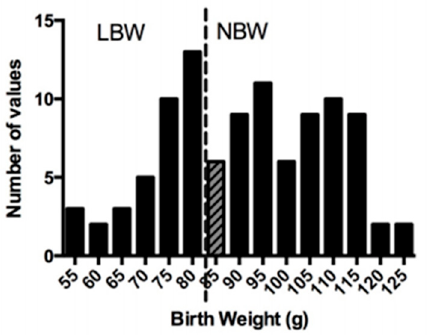
Figure 1. Birth weight distribution. Pregnant guinea pigs underwent uterine artery ablation at mid-gestation. At the end of pupping period, pups born below the 25th percentile (dashed line) were classified as low birth weight (LBW), and those above the 25th percentile were classified as normal birth weight (NBW). Animals between 85 g and 90 g (grey hatched bar) were excluded from further analyses.